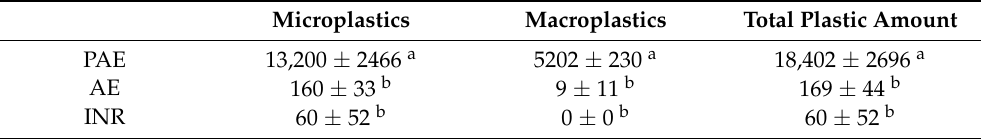
Table 1. Plastic fragments counts in 1 kg of soil from the Polluted AgroEcosystem (PAE), the AgroEcosystem (AE), and the integral natural reserve (INR). The values displayed are the mean values ± standard deviation. Values with different letters in the same column are significantly different ( p < 0.05, ANOVA